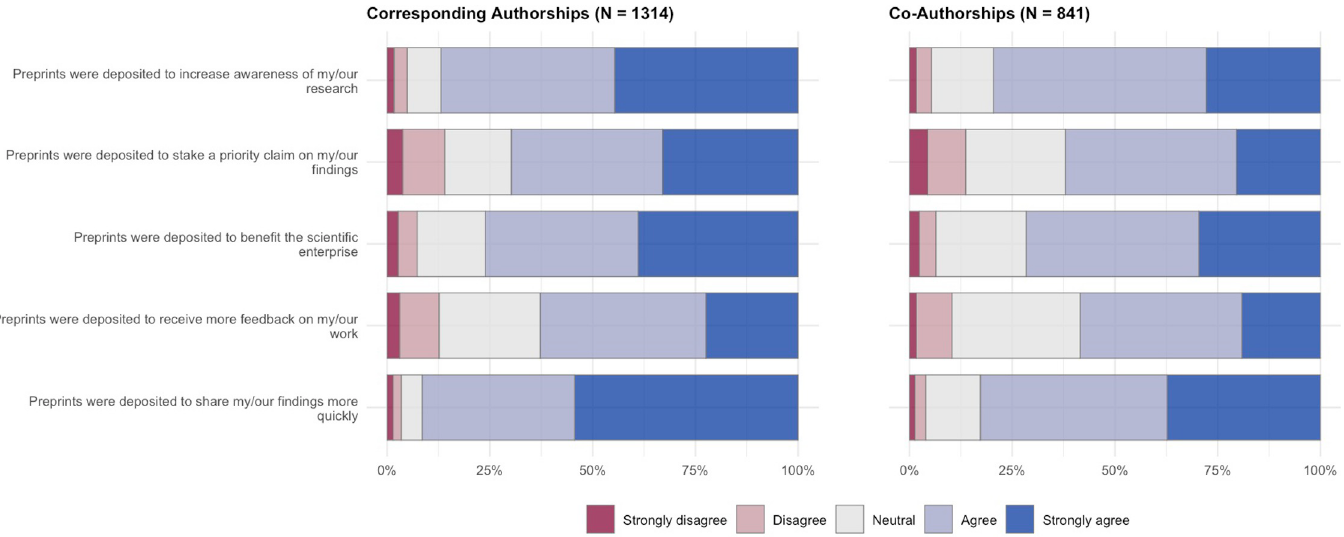
Fig 5. Motivations for posting preprints. Results show answers to survey questions on a 5-point Likert scale, divided by articles that authors published as a corresponding author (left) and articles that authors published as a co-author (right).